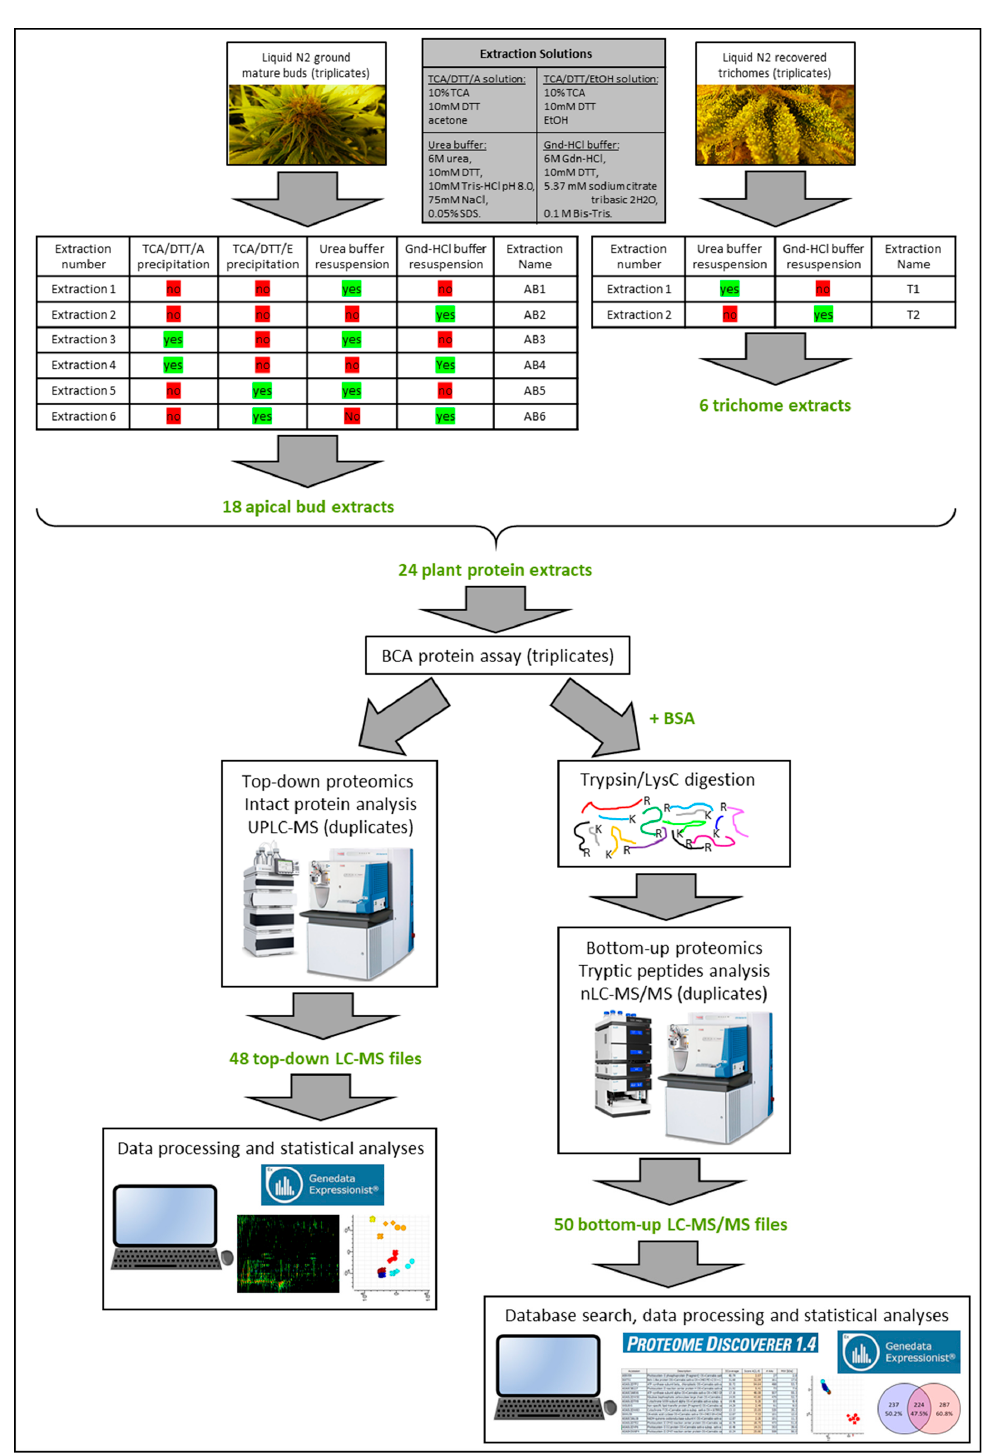
Figure 1. Experimental design.